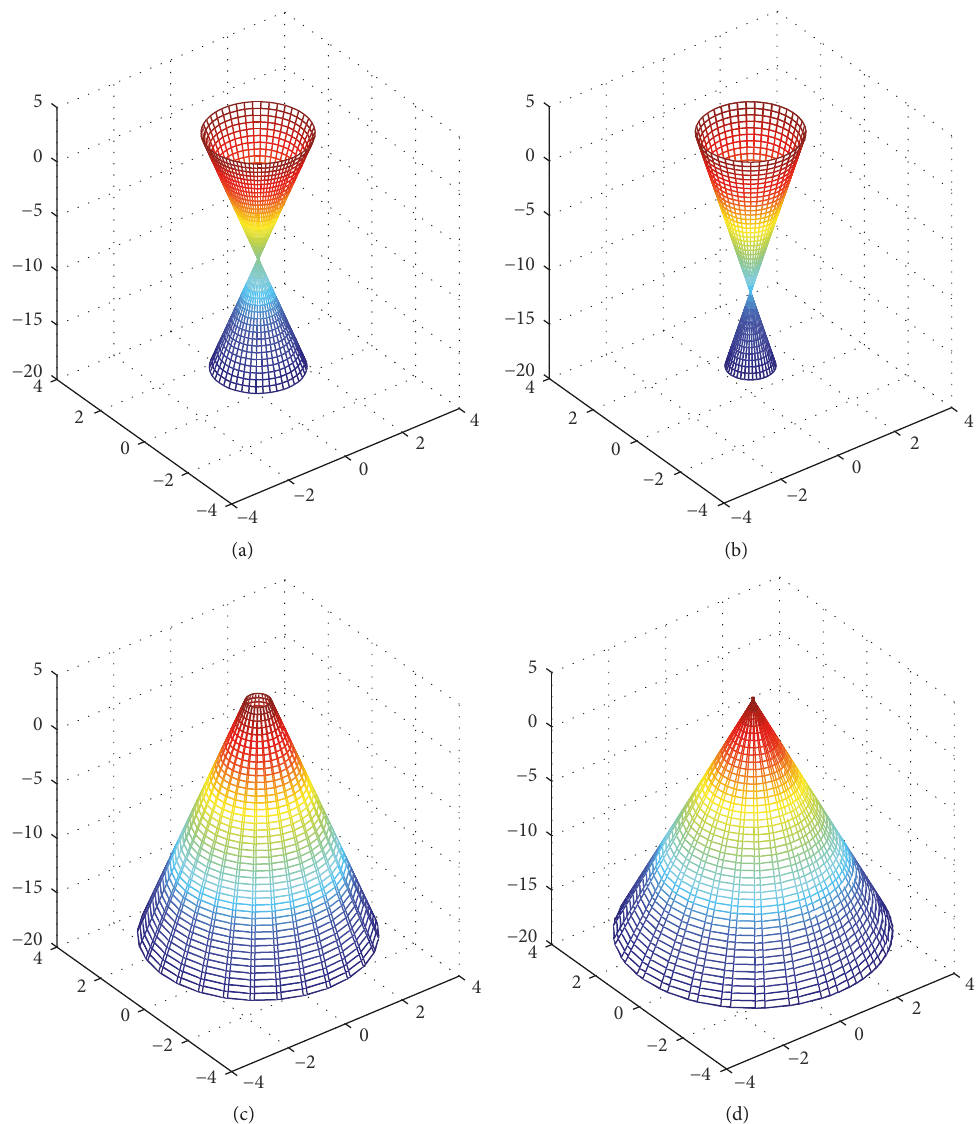
Figure 11: Vibration modes obtained with the Rigid Body Model, with the generator excited: (a) 1st mode (backward precession at 4.71 Hz); (b) 2nd mode (direct precession at 5.12 Hz); (c) 3rd mode (backward precession at 7.18 Hz); (d) 4th mode (direct precession at 7.91Hz).